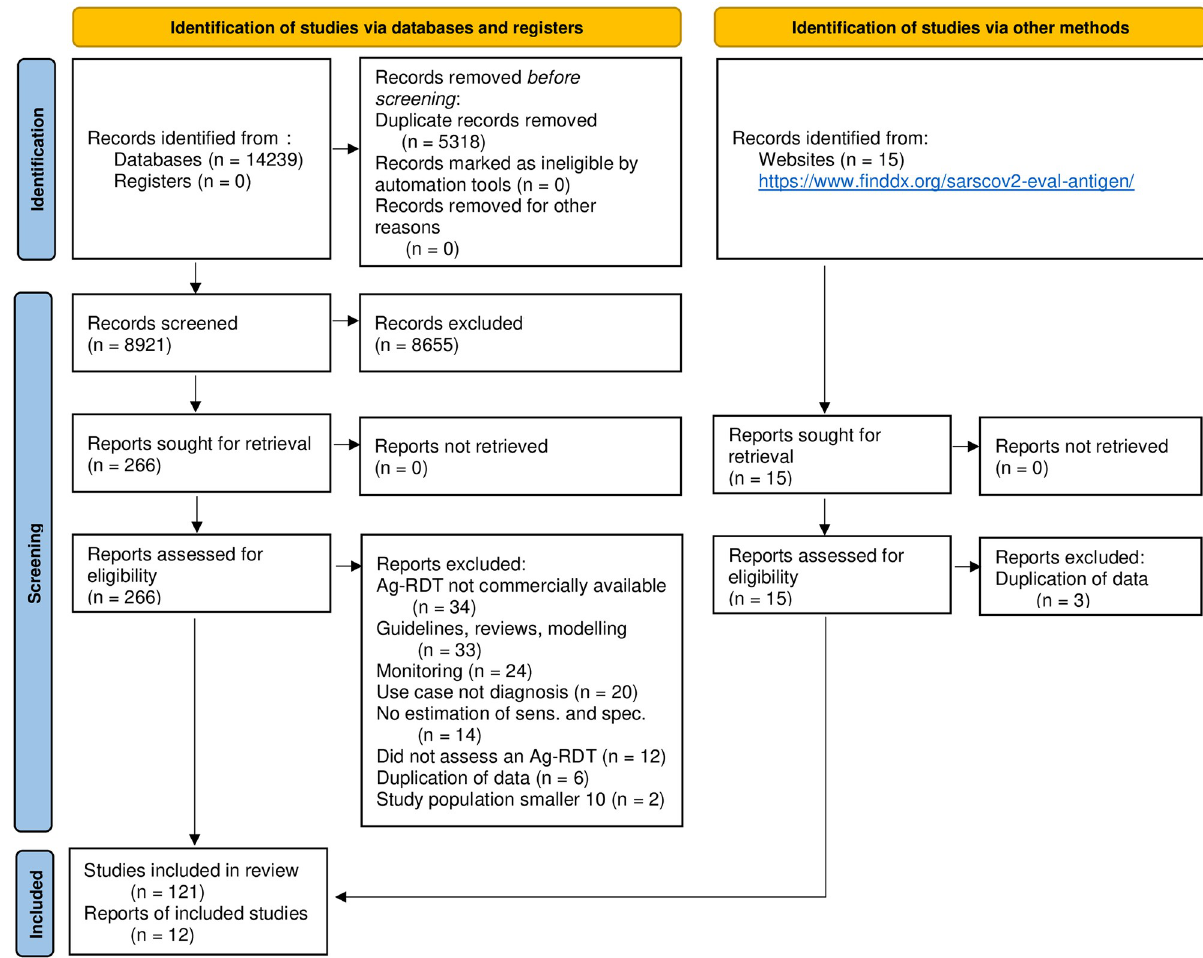
Fig 1. PRISMA flow diagram. Based on Page et al. [297]. Ag-RDT, antigen rapid diagnostic test; IFU, instructions for use; sens., sensitivity; spec., specificity.